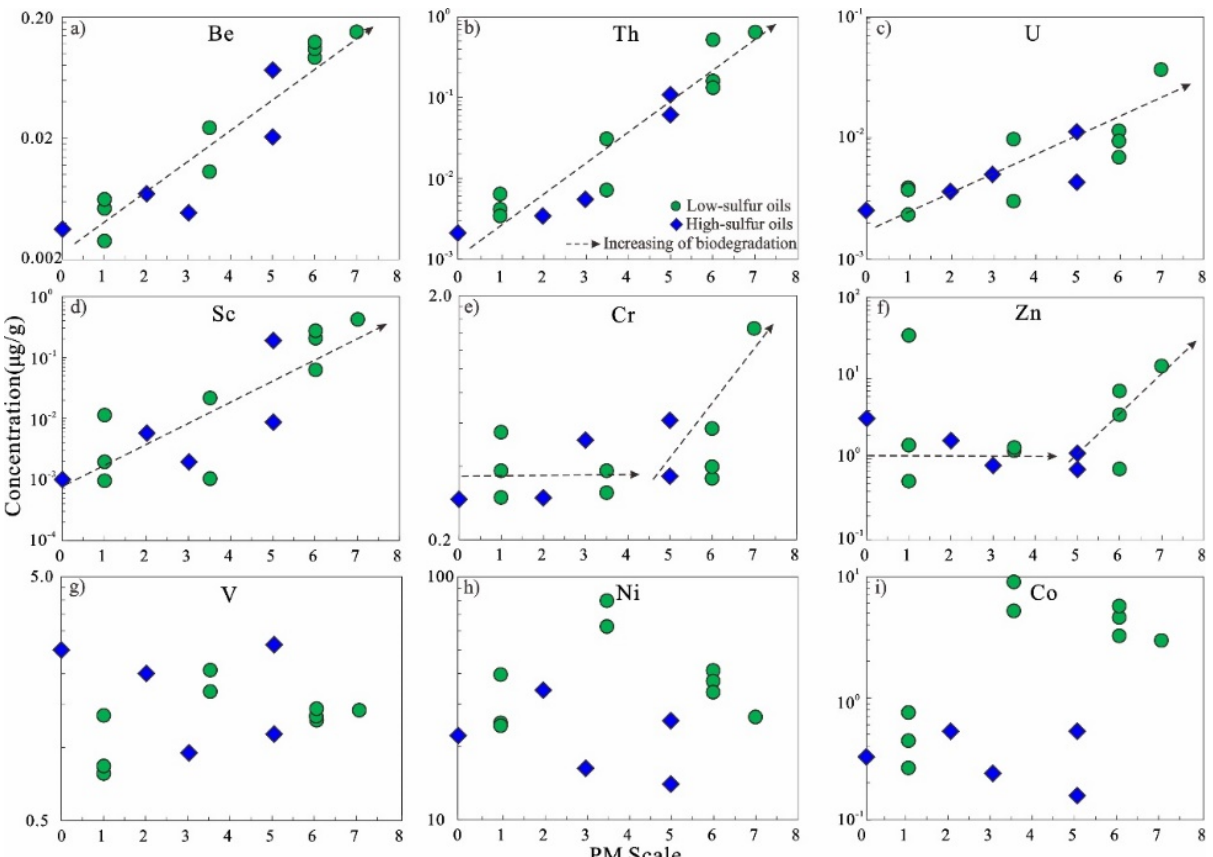
versus Ca; ( c ) Cross plot of PM Scale versus Mn; ( d ) Cross plot of PM Scale versus Fe; ( e ) Cross plot of PM Scale versus Na; ( f ) Cross plot of PM Scale versus K; ( g ) Cross plot of PM Scale versus Ti; ( h ) Cross plot of PM Scale versus Al; ( i ) Cross plot of PM Scale versus P.